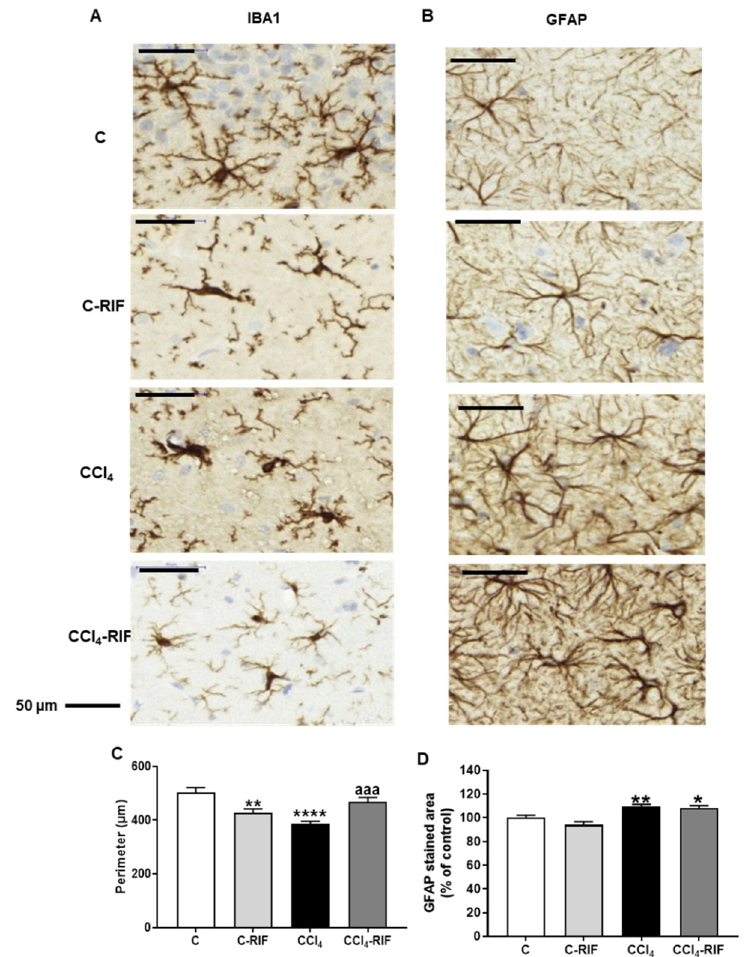
Figure 1. Astrocyte and microglia activation in the hippocampus. The perimeter of the microglia (stained with Iba1 marker ( A )) and the percentage of GFAP stained area ( B ) was analyzed. Values are the mean ± SEM of 8 rats per group. In ( C ) the data were analyzed using the non-parametric Kruskal–Wallis test and Dunn’s multiple comparisons test. In ( D ) the data were analyzed using a one- way ANOVA and Tukey’s multiple comparisons test. The asterisks indicate a significant difference with respect to the control group * p < 0.05, ** p < 0.01, **** p < 0.0001, “aaa” p < 0.001. C: